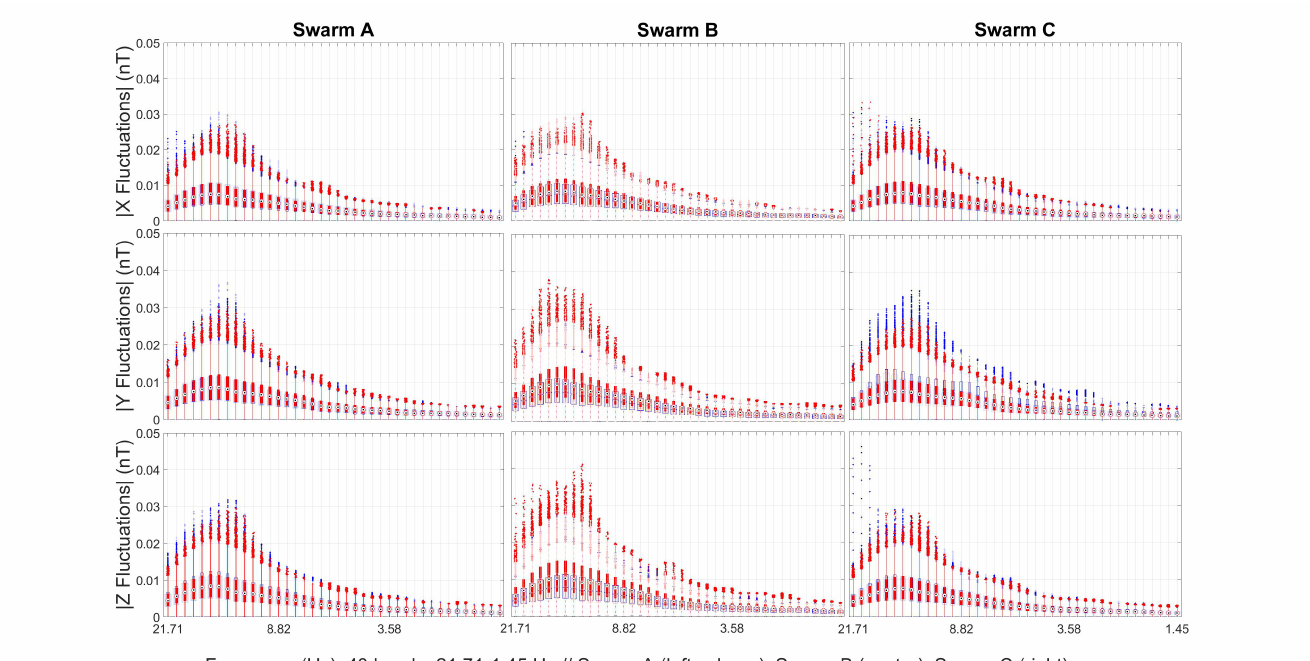
Figure 9. Distribution of Swarm A/B/C VFM magnetic field fluctuations after wavelet analysis grouped in individual frequency bands for the SpaceX Falcon 9 launch, Vandenberg Air Force Base, California, USA. The spatial box size is ± 5.5 deg, date 21 November 2020 (payload Sentinel-6 Michael Freilich satellite), and time span ± 1 day. For Swarm B VFM (middle column) the individual crossing segments relative to the take off moment are ∆ t = { − 0.40, +0.11, +0.59, +1.10} days. All three components for the first crossing after the launch ( ∆ t = {+0.11} days) are enhanced (bars in red colour). The colour coding is the same as in Figure 2, the geomagnetic activity is | Dst | ≤ 38 nT for the selected time